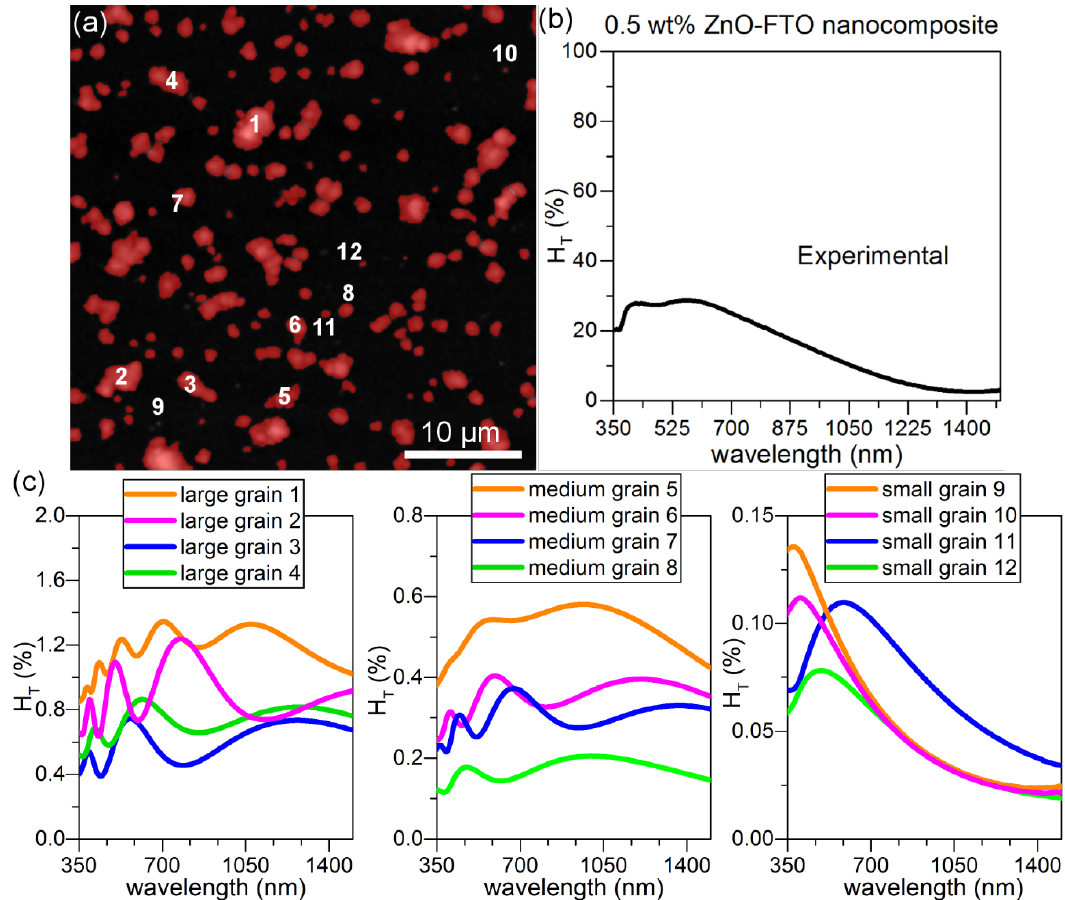
Figure 9. ( a ) AFM image of 40 × 40 μm 2 for a 0.5 wt % ZnO-FTO nanocomposite. Here the nanoparticle agglomerates are colored in red with the help of Gwyddion software [28]; ( b ) Plot of H T (λ) (measured experimentally) for 0.5 wt % ZnO-FTO nanocomposite; ( c ) Simulated H T (λ) of FTO nanocomposite containing a single grain of those marked 1–12 in ( a ), respectively. Here the specular light is considered as the central one pixel only.